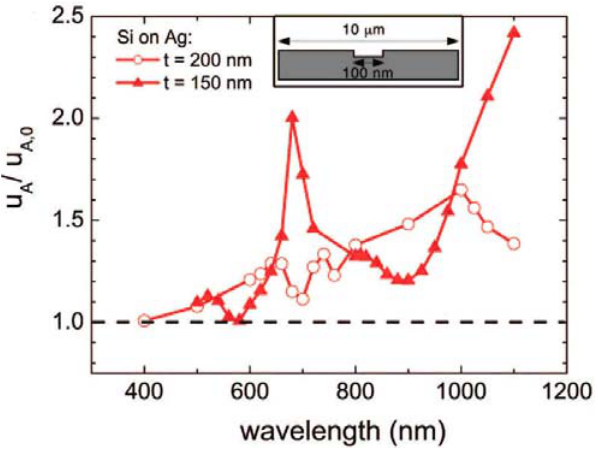
Figure 8. Absorption enhancement for a 100 nm wide by 50 nm deep Ag groove for different thicknesses of silicon film, relative to the identical thin-film with no groove (reprinted with permission from [40]. © 2008, American Chemical